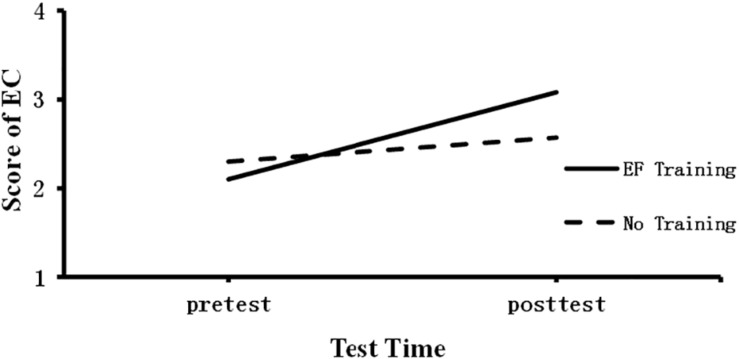
Children’s Score of EC during pre–posttest.